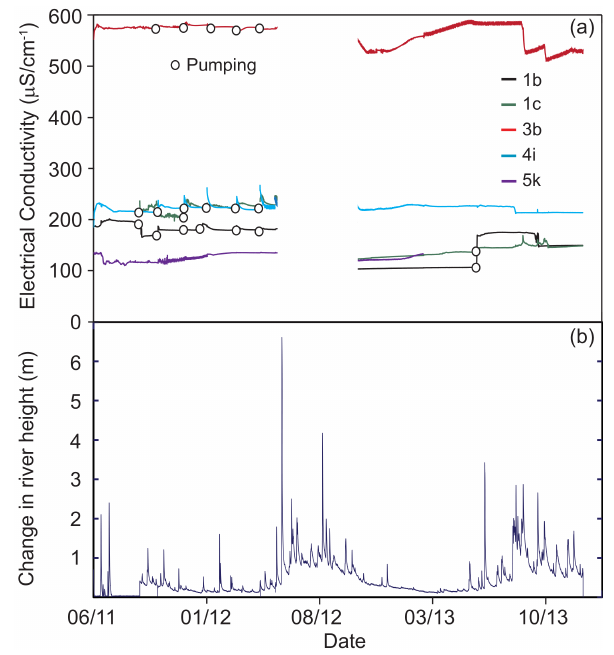
Figure 5. (a) Continuous electrical conductivity monitoring of near- river groundwater. (b) Changes in river height over the study period. Groundwater EC and river level data from deployed Aqua TROLL 200 (in situ) data loggers.